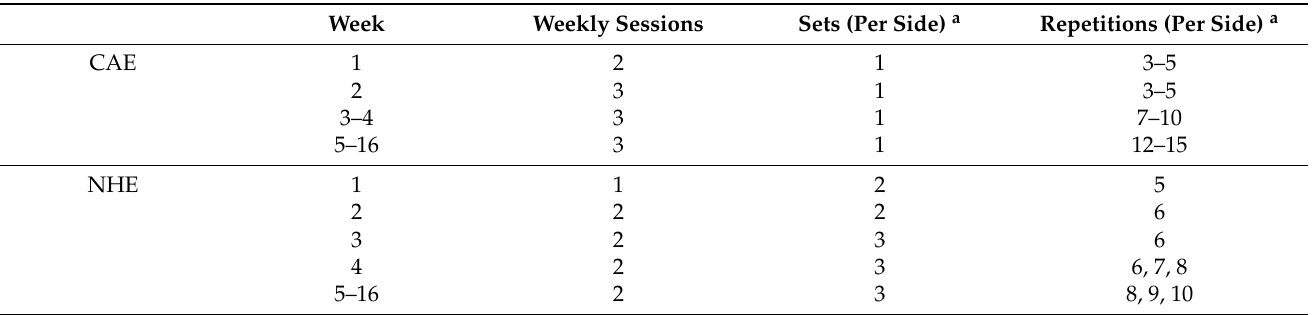
Table 1. Training protocol for Copenhagen adduction exercise (CAE) and Nordic hamstring exercise